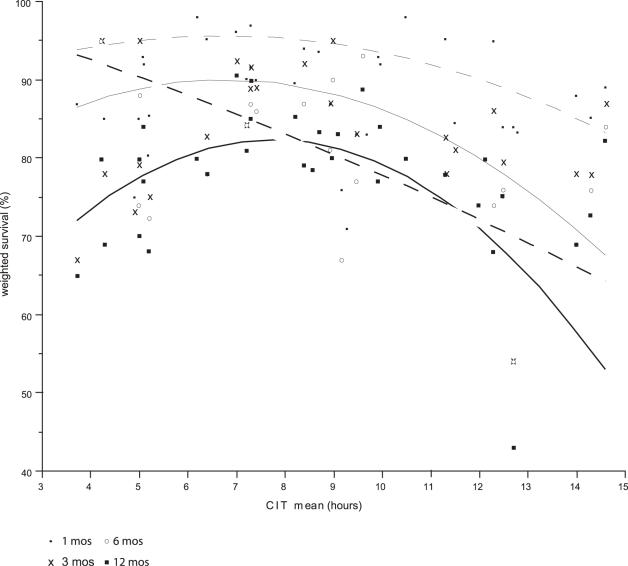
Graft Survival at 1, 3, 6 and 12 months versus mean CIT.